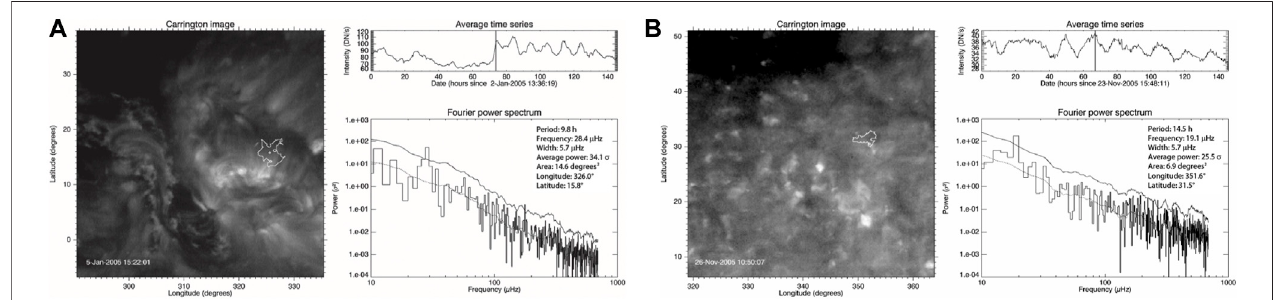
FIGURE 20 | Detection of pulsations outside of loops structures. (A) Pulsations detected in an active region but that does not appear to be linked to a visible loop structure. (B) Pulsations detected in the quiet Sun. In each panel the SoHO/EIT 195 Å fi eld-of-view is presented in heliographic coordinates. The top light curves are averaged over the white contour in the images. The Fourier spectra of these light curves are presented below. Both Figures are adapted from Auchère et al. (2014) (Figures 2, 3, reproduced with permission © ESO). See the original paper for more